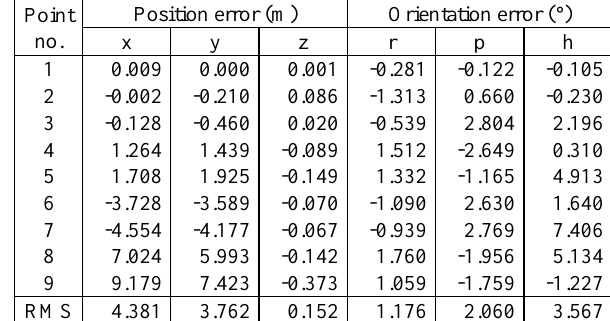
Figure 8. Rail-bound navigation results, (A) System velocity in body-frame and (B) System